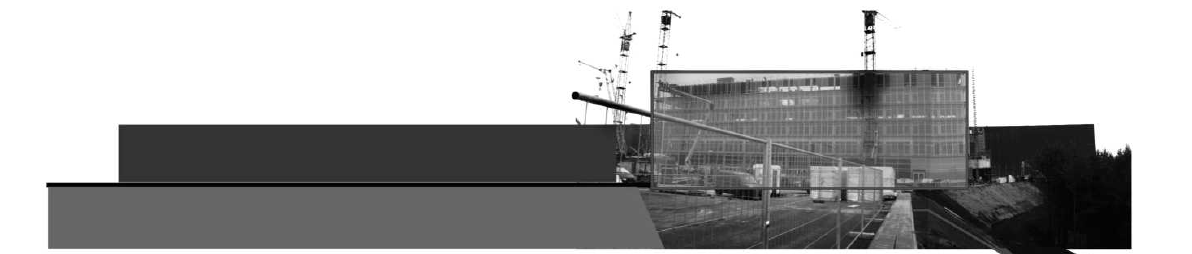
Fig 4. “Akropolis” administrative buildings on Ozo Street, Vilnius (arch G. Jurevičius,